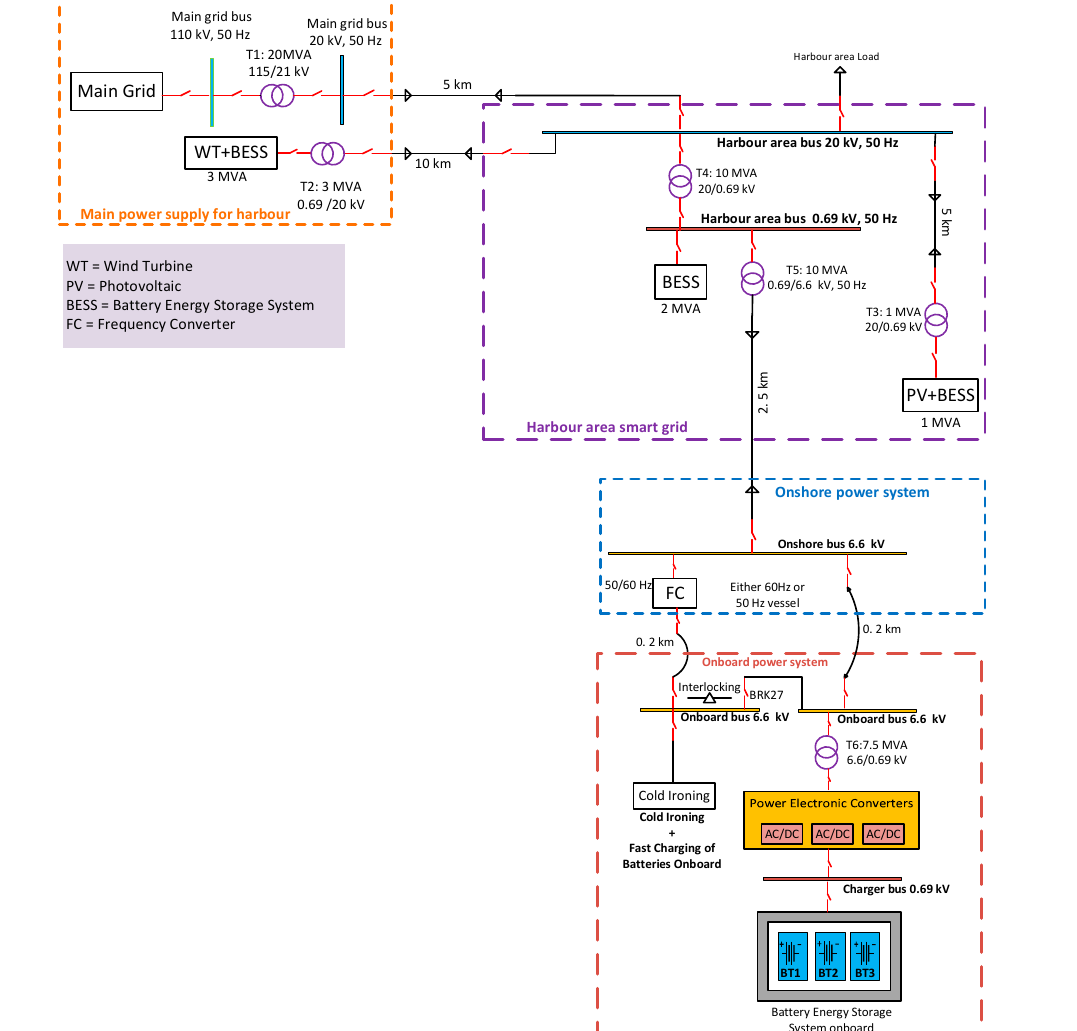
Figure 5. Configuration D: Fast charging of onboard batteries and cold-ironing from the same onshore AC power supply.